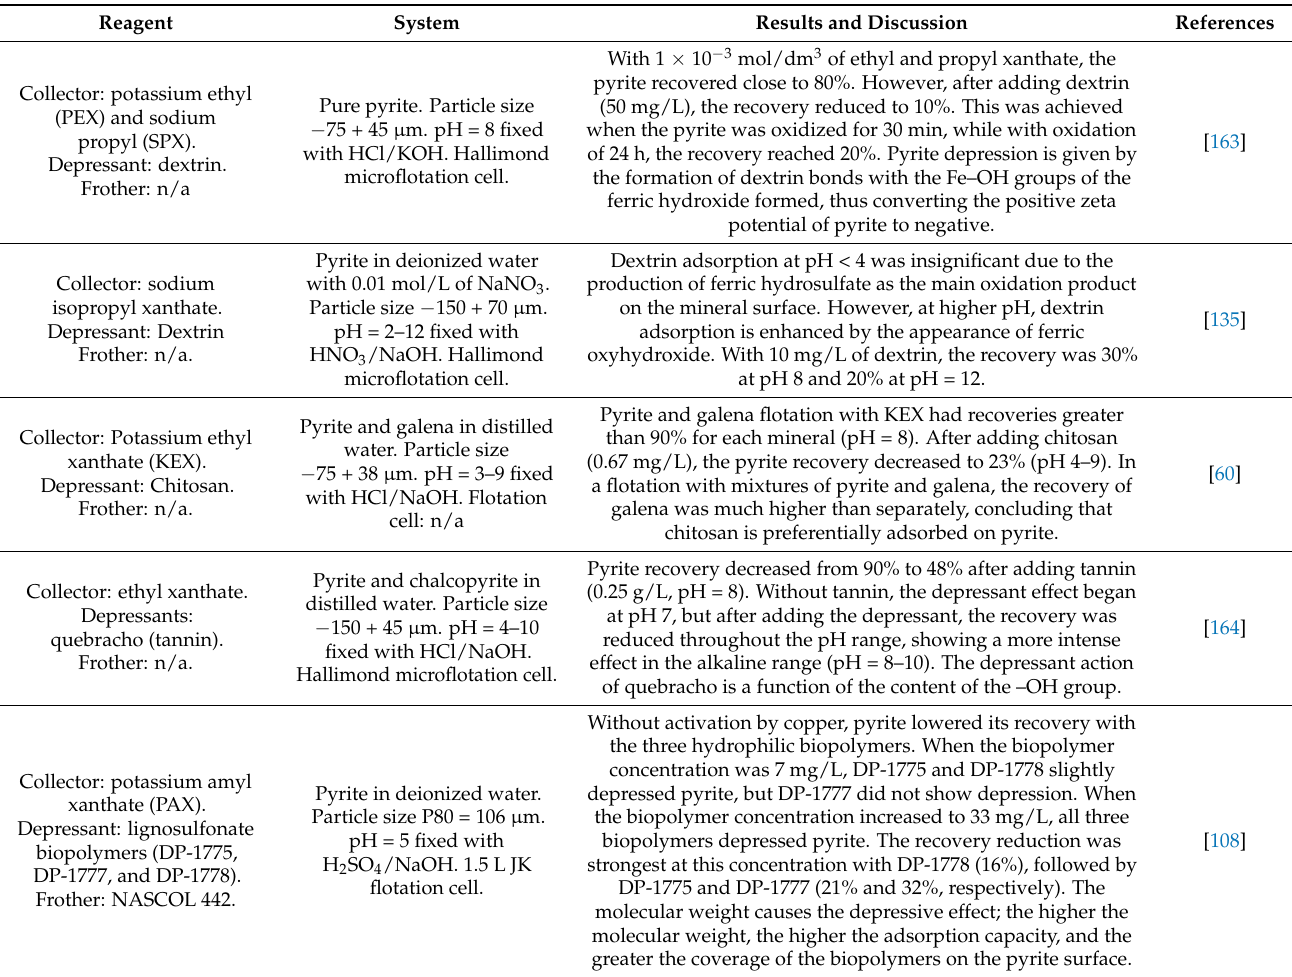
Table 5. Summary of studies of pyrite depressants in flotation